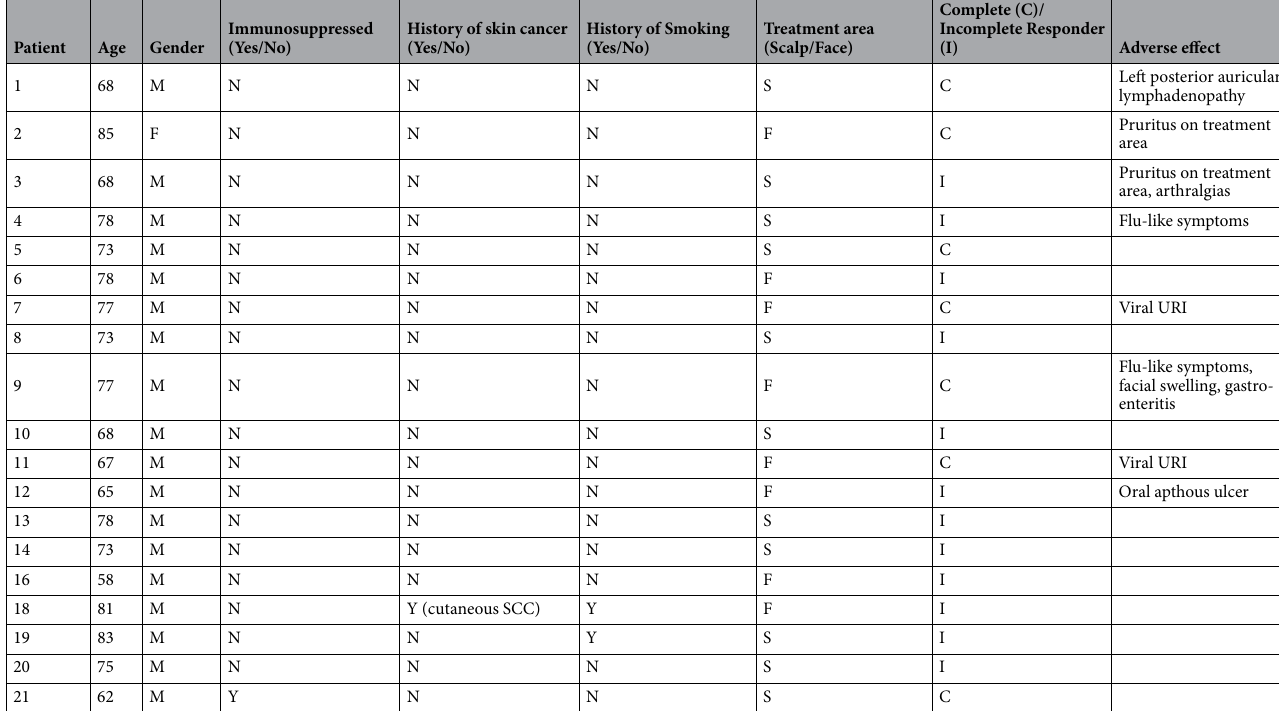
Table 1. Demographic information and treatment response in all patients included in the analysis. *Patients 15 and 17 initial biopsy showed SK and thus are excluded from this